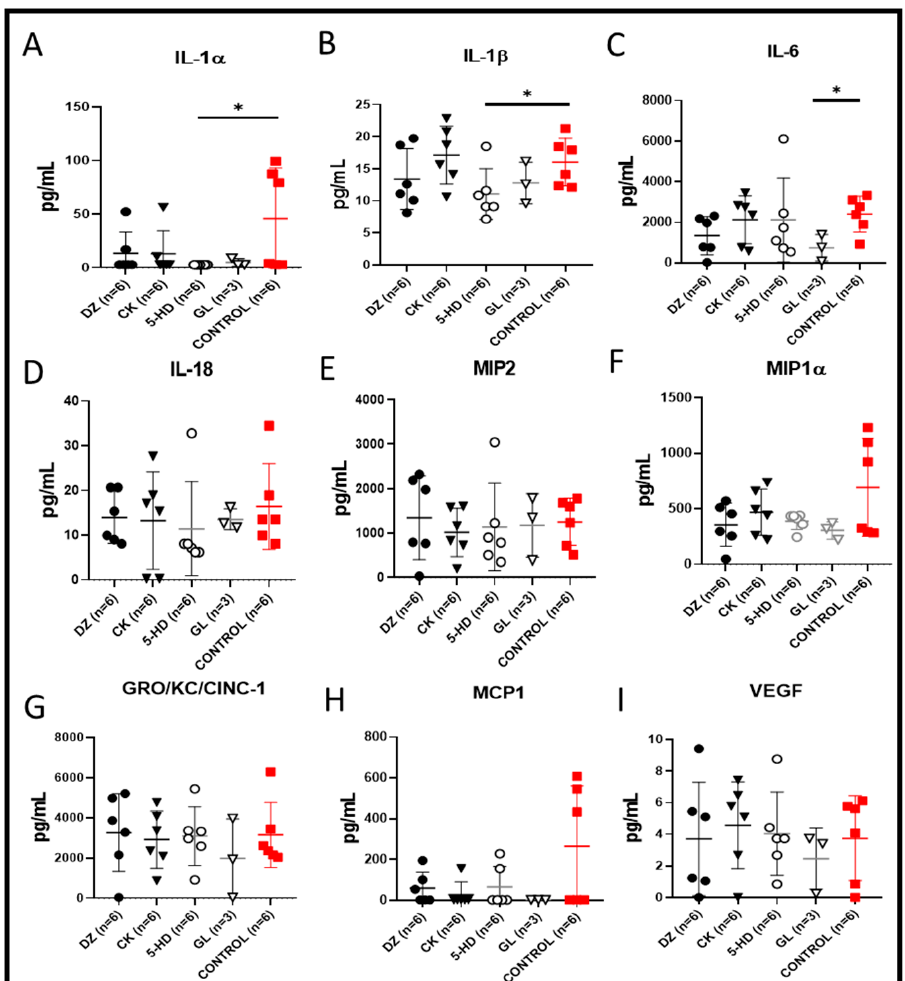
Figure 4. Perfusate concentration of cytokines, chemokines and mediator of wound healing after 4 h of EVLP. ( A ) Interleukin-1 beta (IL-1 β ) and ( B ) interleukin-1 alpha (IL-1 α ) were significantly lower with 5-HD (* p < 0.05), whereas ( C ) IL-6 was significantly lower with GL when compared to the control (* p < 0.05). ( D ) IL18, ( E ) MIP2, ( F ) MIP-1 α , ( G ) GRO/KC/CINC-1, ( H ) MCP-1, and ( I ) VEGF were reduced in the presence of the channel blockers 5-HD and GL, but these levels were not significantly lower than the control value.